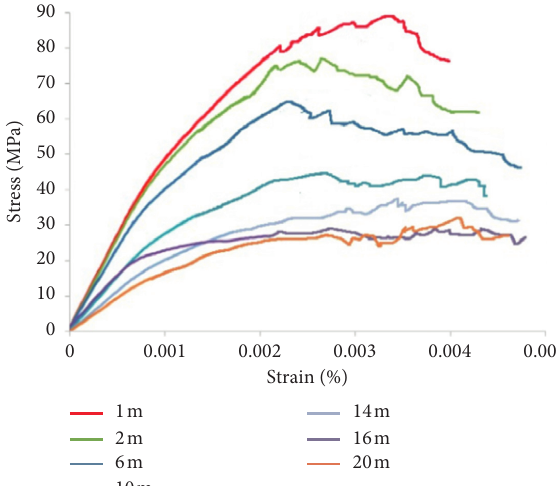
Figure 13: Stress-strain curve of the multiscale SRM model.